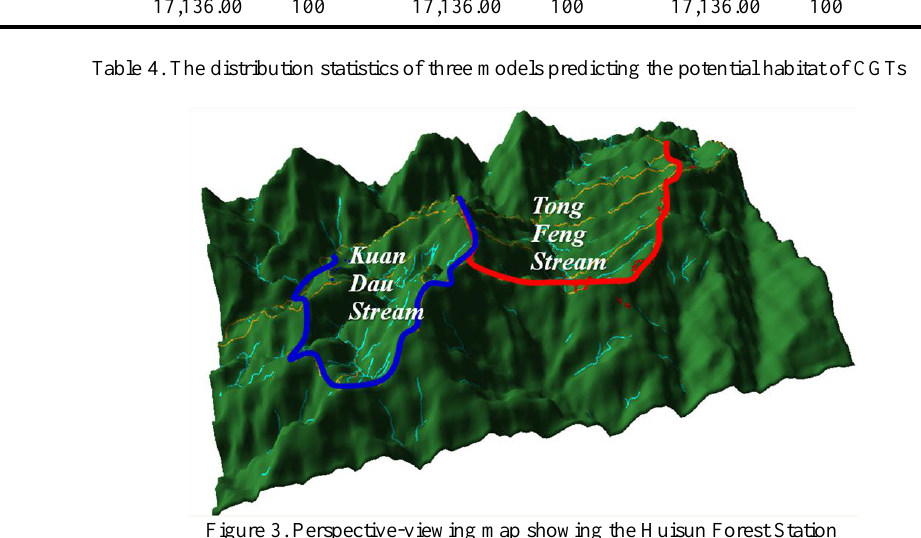
Figure 3. Perspective-viewing map showing the Huisun Forest Station